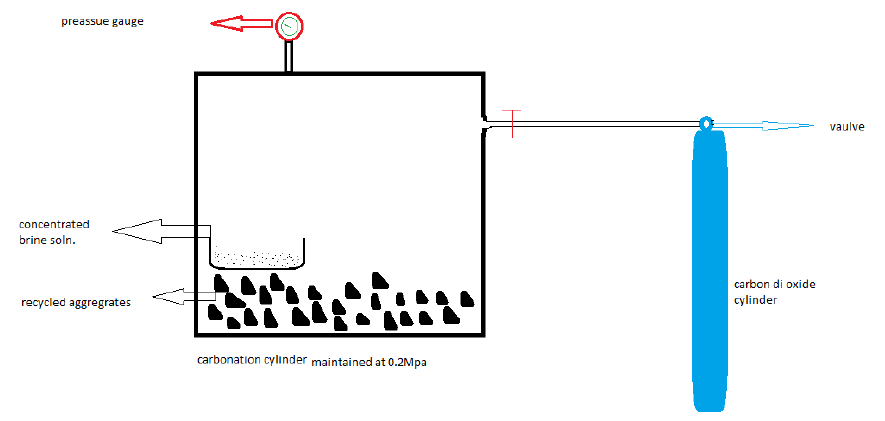
Fig. 5. Carbonation chamber line diagram